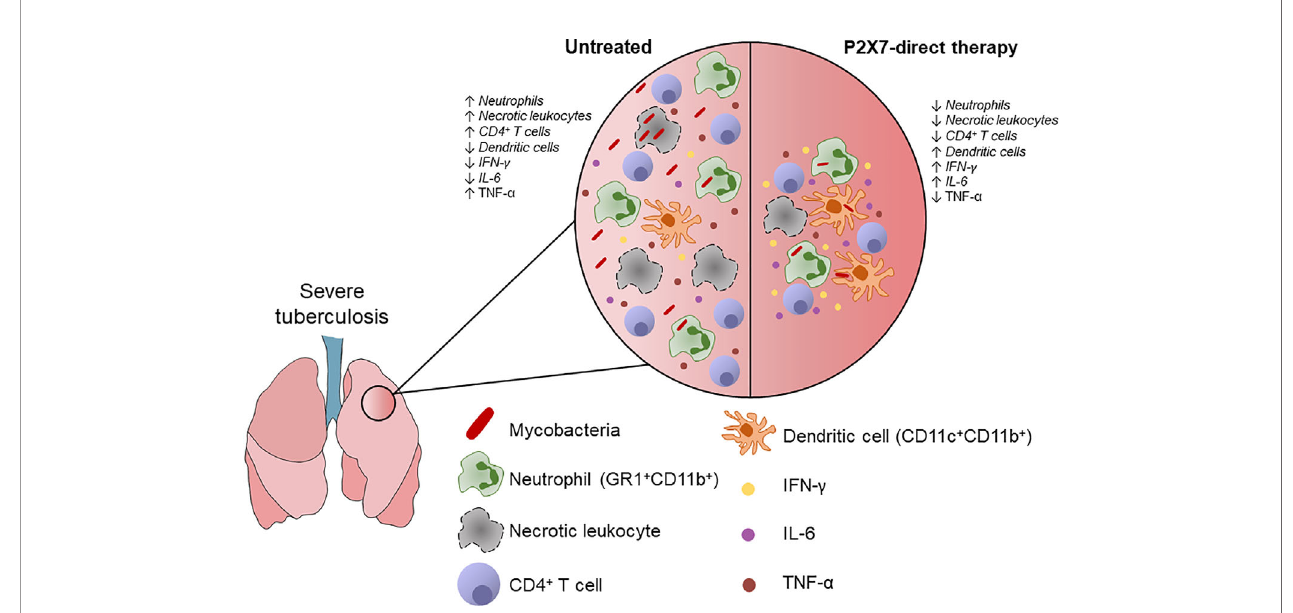
FIGURE 5 | Schematic illustration shows the effects of P2X7-directed therapy on the pulmonary in fl ammatory response to hypervirulent mycobacterial infection. P2X7-mediated necrotic death of lung leukocytes promote bacillus spread and ATP release to the extracellular milieu. Extracellular ATP at high concentration stimulates the P2X7 receptor and exacerbates in fl ammatory and necrotic lung lesions. The P2X7-direct therapy reduces the recruitment of lung leukocytes, particularly neutrophils (GR1 + CD11b + ), as well as the production of TNF- a . The effector CD4 + T cell population was also decreased, but IFN- g production by lung cells was increased. P2X7 inhibition also increases the population of myeloid dendritic cells (CD11c + CD11b + ) and the production of IL-6 by lung cells, indicating a qualitative improvement in the pulmonary immune response. This scenario supports the use of therapeutic interventions in the P2X7 receptor to increase the effectiveness of anti-microbial treatment and reduce the severity of pulmonary